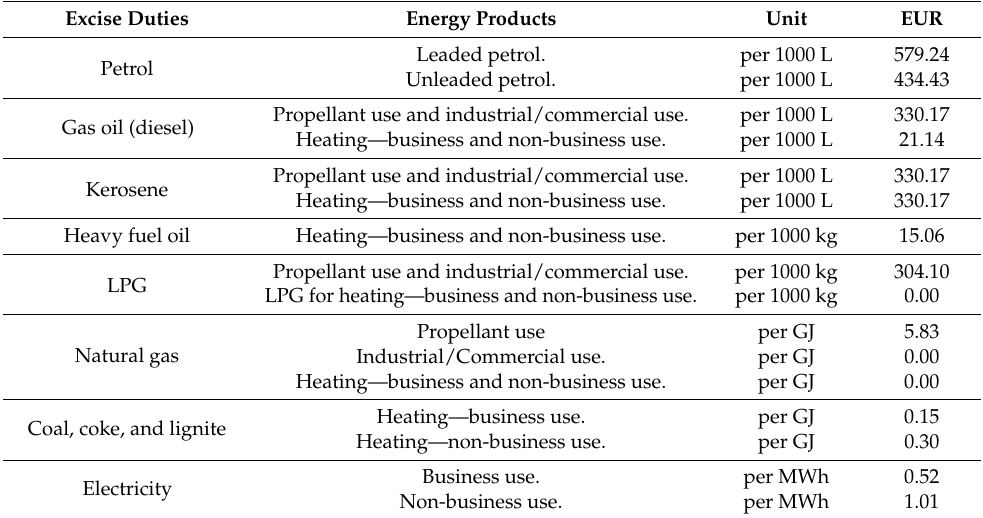
Table 5. Excise duties in Lithuania, 2015